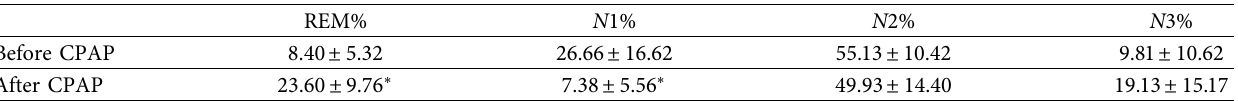
Table 2: The proportion of sleep in different stages of patients with CSAS before and after continuous positive airway pressure (CPAP) treatment.